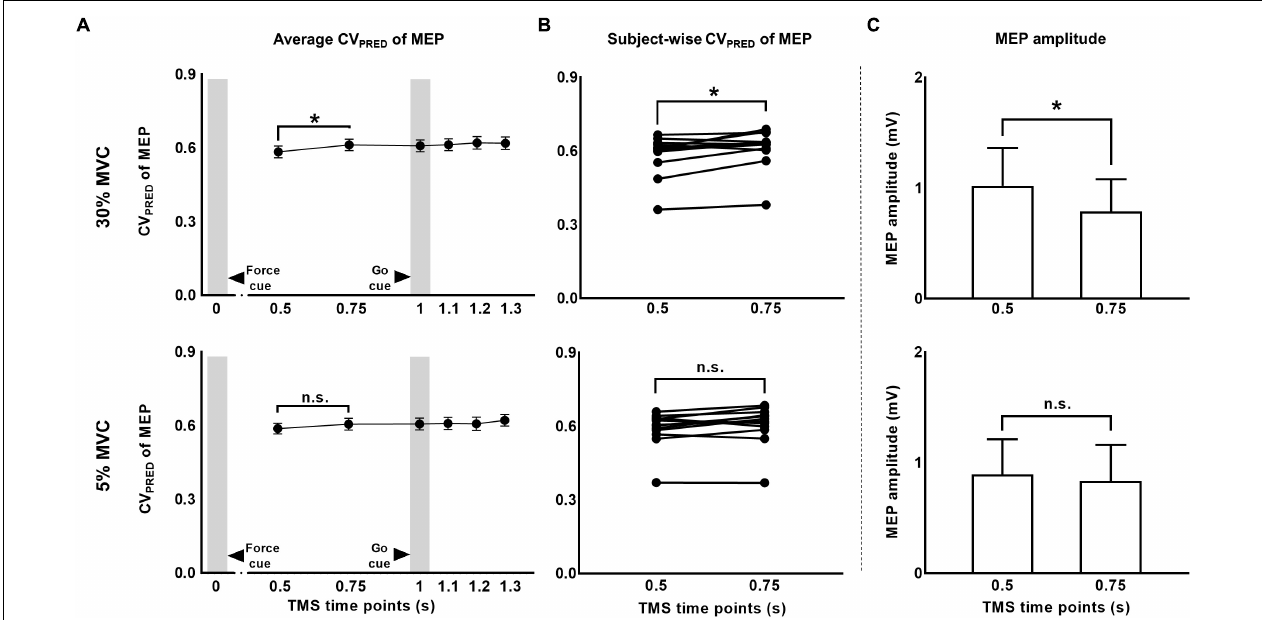
FIGURE 5 | The CV of motor evoked potentials (MEP) due to changes in MEP amplitude. (A) Time-course of predicted CV of MEP at 30% compared to 5% of force. (B) Subject-wise predicted CV of MEP data indicates a consistent rise across subjects from 0.5 to 0.75 s at 30%, but not at 5% of force. (C) A significant reduction in MEP amplitude from 0.5 to 0.75 s explained the rise in predicted CV of MEP at 30% of force. Data in (A,C) are averages of all subjects (vertical bars denote SE). Asterisks indicate p < 0.016 and n.s. indicates p > 0.05.